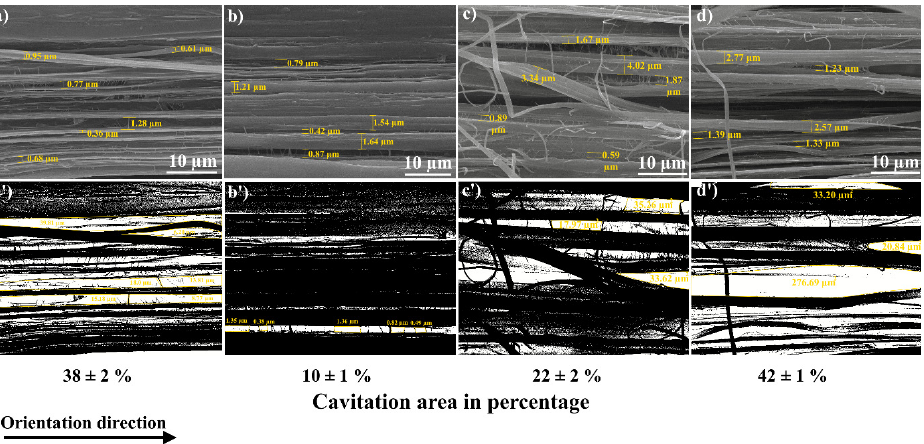
Figure 6. SEM micrographs of fibrillar structure for UHMWPE films obtained by first thermal ori- entation regime: ( a )—virgin UHMWPE (average pore size is 1.2 ± 0.2 µm), ( b )—UHMWPE/1.0% PE- orientation regime: ( a )—virgin UHMWPE (average pore size is 1.2 ± 0.2 µ m), ( b )—UHMWPE/1.0% wax (average pore size is 0.8 ± 0.2 µm), ( c )—UHMWPE/1.0 wt. % PE-wax/0.01 wt. % GNP/PAN PE-wax (average pore size is 0.8 ± 0.2 µ m), ( c )—UHMWPE/1.0 wt. % PE-wax/0.01 wt. % GNP/PAN (average pore size is 3.4 ± 0.5 µm), ( d )—UHMWPE/1.0 wt. % PE-wax/2.0 wt. % GNP/PAN (average (average pore size is 3.4 ± 0.5 µ m), ( d )—UHMWPE/1.0 wt. % PE-wax/2.0 wt. % GNP/PAN (average pore size is 3.7 ± 0.4 µm); ( a’ – d’ )—modified SEM images using the image J program. pore size is 3.7 ± 0.4 µ m); ( a’ – d’ )—modified SEM images using the image J